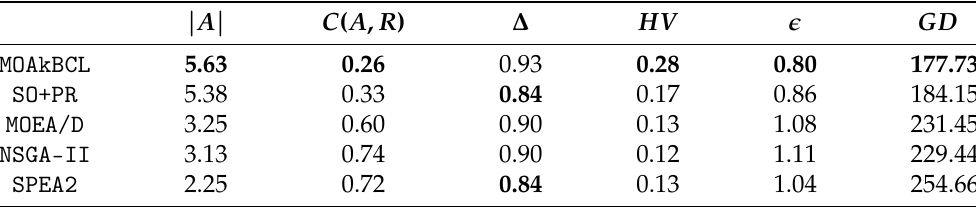
Table 4. Average results for the k -BCL 12 on the S1 and A3 instances.